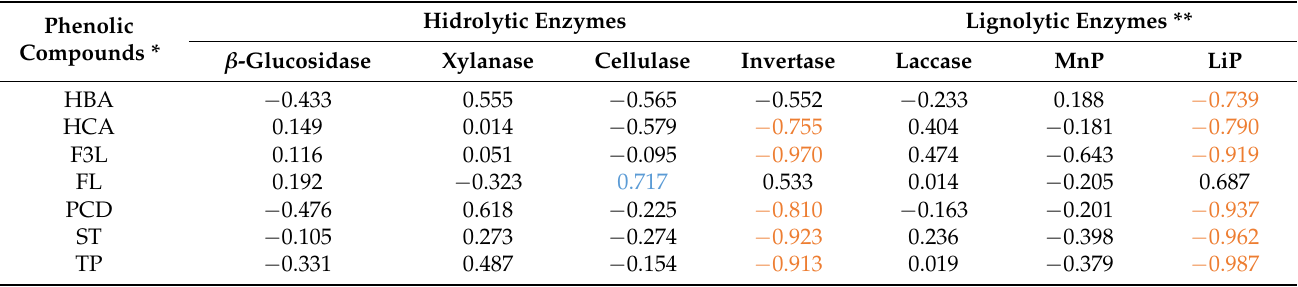
Orange values—a strong negative correlation. Blue values—a strong positive